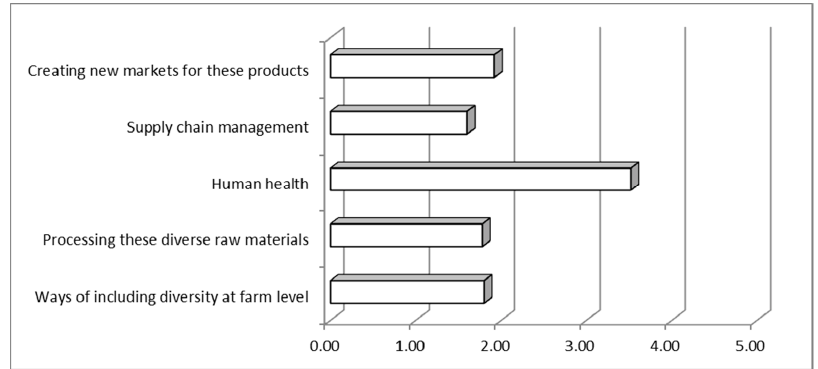
Figure 4. Scores assigned to the evaluated papers in the “practical implication” screening form.